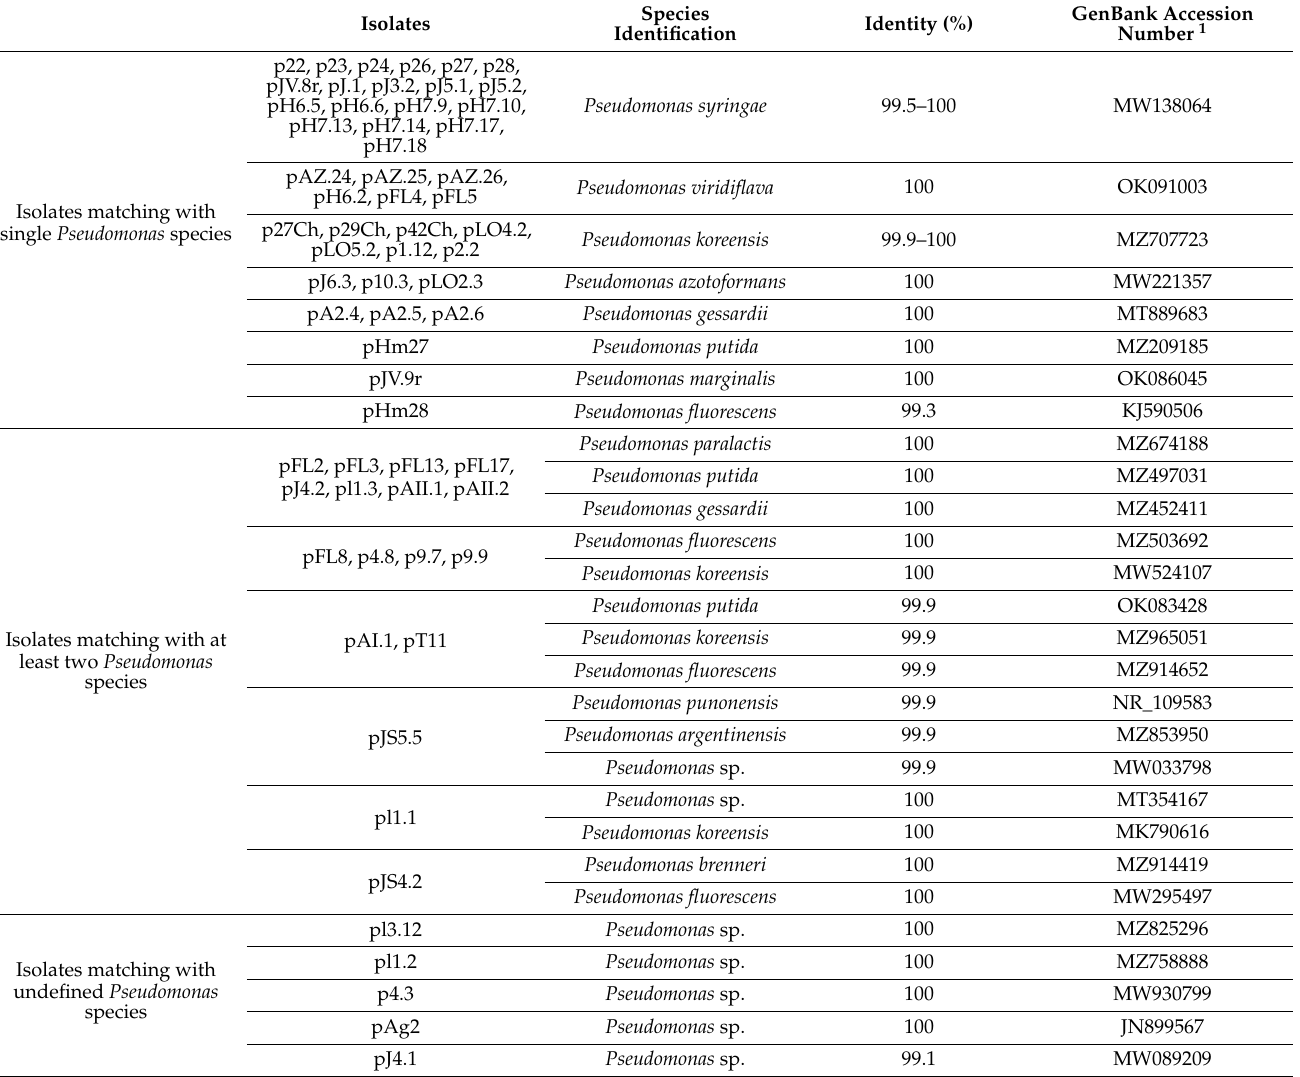
Table 4. Bacterial species most closely related to Pseudomonas spp. isolates based on identity of 16S rRNA gene